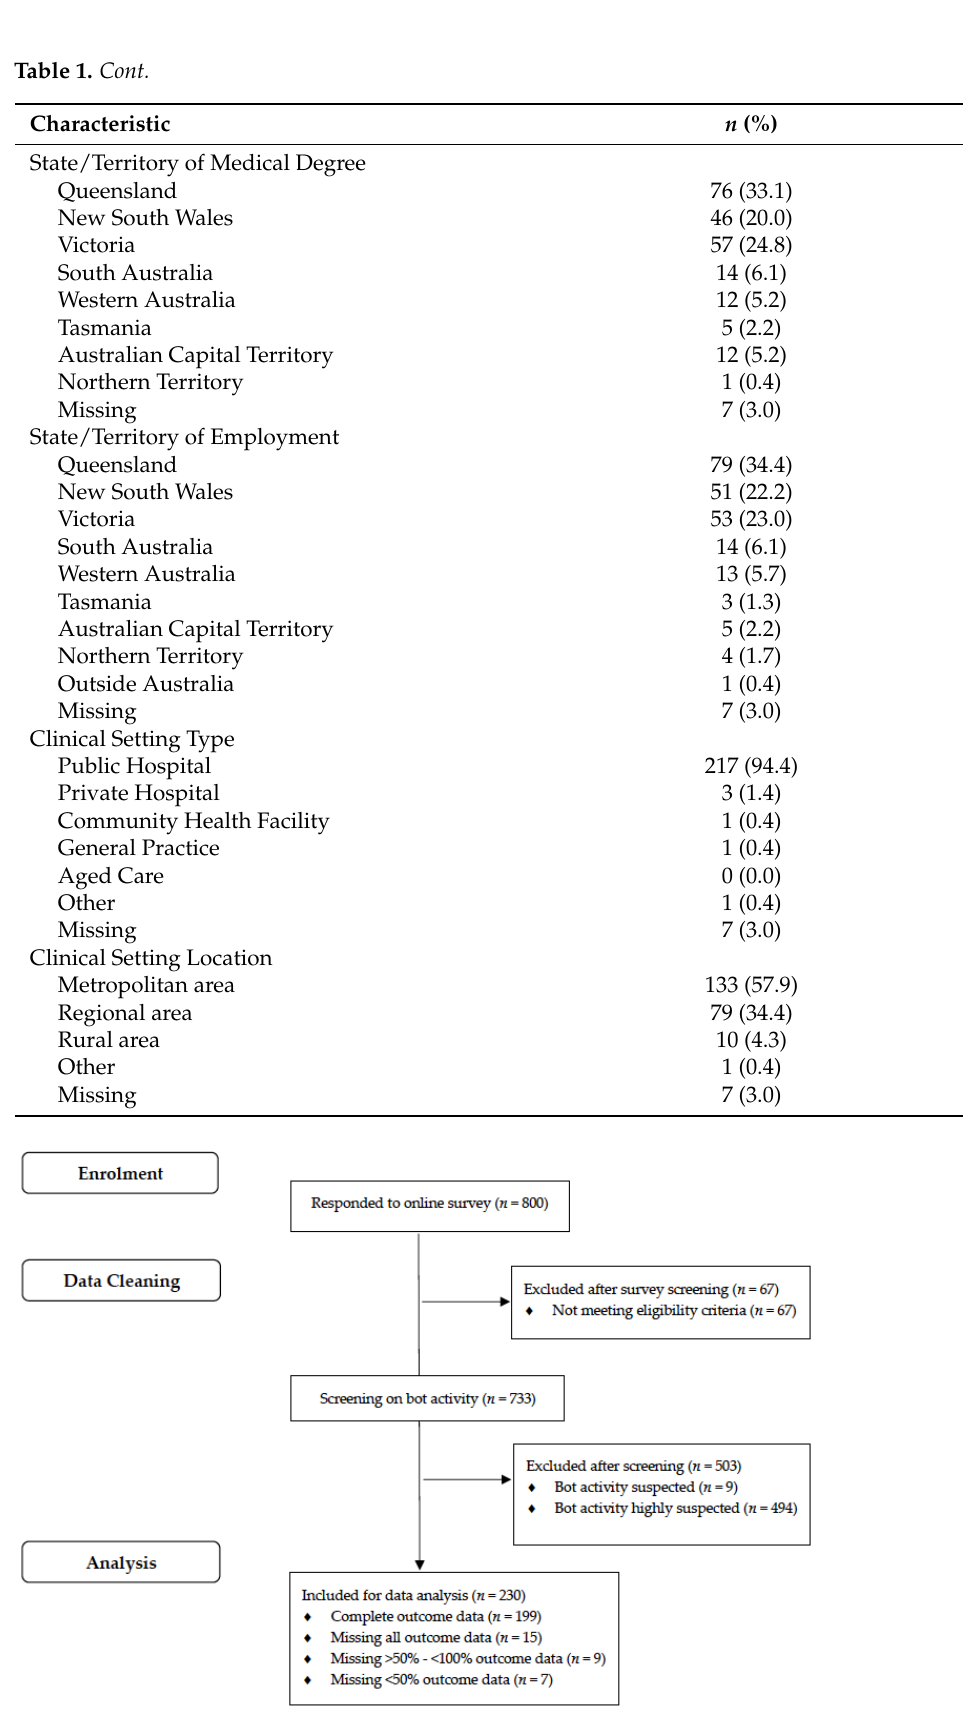
Figure 1. Flowchart of participant recruitment and data cleaning. Table 1. Participant characteristics of the total sample ( n = 230).